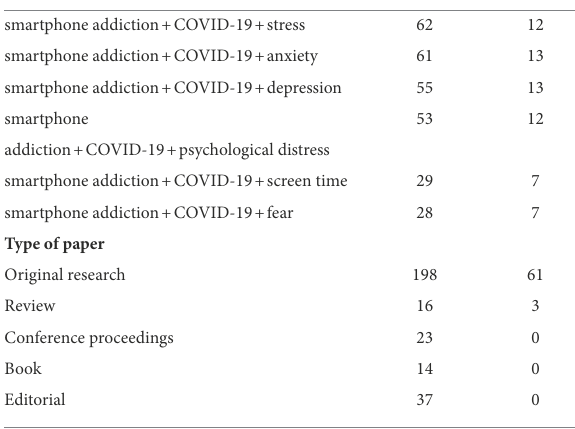
TABLE 1 Topics and types of scientific products identified and selected.